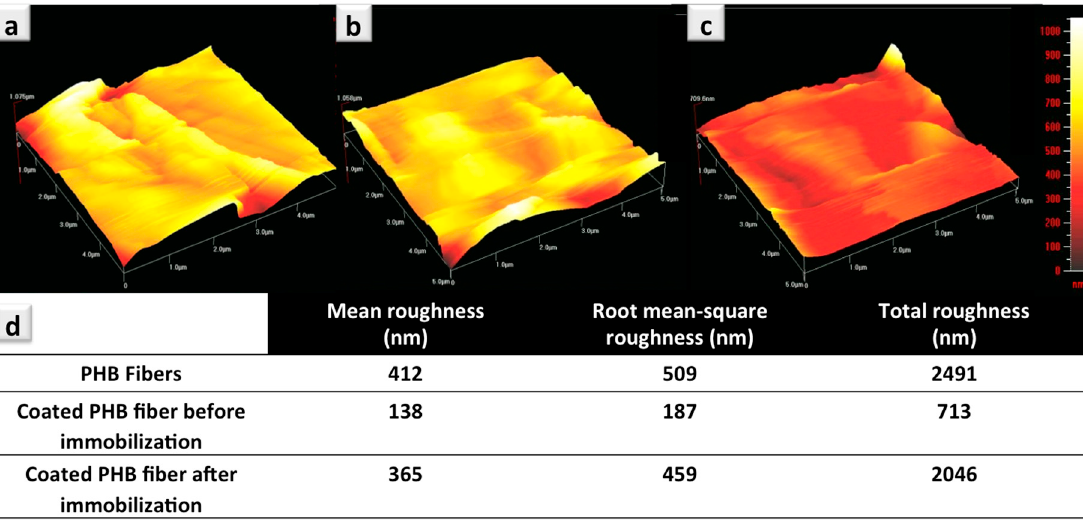
Figure 5. Topography analysis of the uncoated and coated electrospun PHB fibers (dimension of the analyzed area = 5 µm  5 µm): pure PHB fibers ( a ); co-polymer coated PHB fibers before ( b ) and after protein immobilization ( c ), as well as surface characteristics of the uncoated and polymer coated PHB fibers measured by AFM ( d